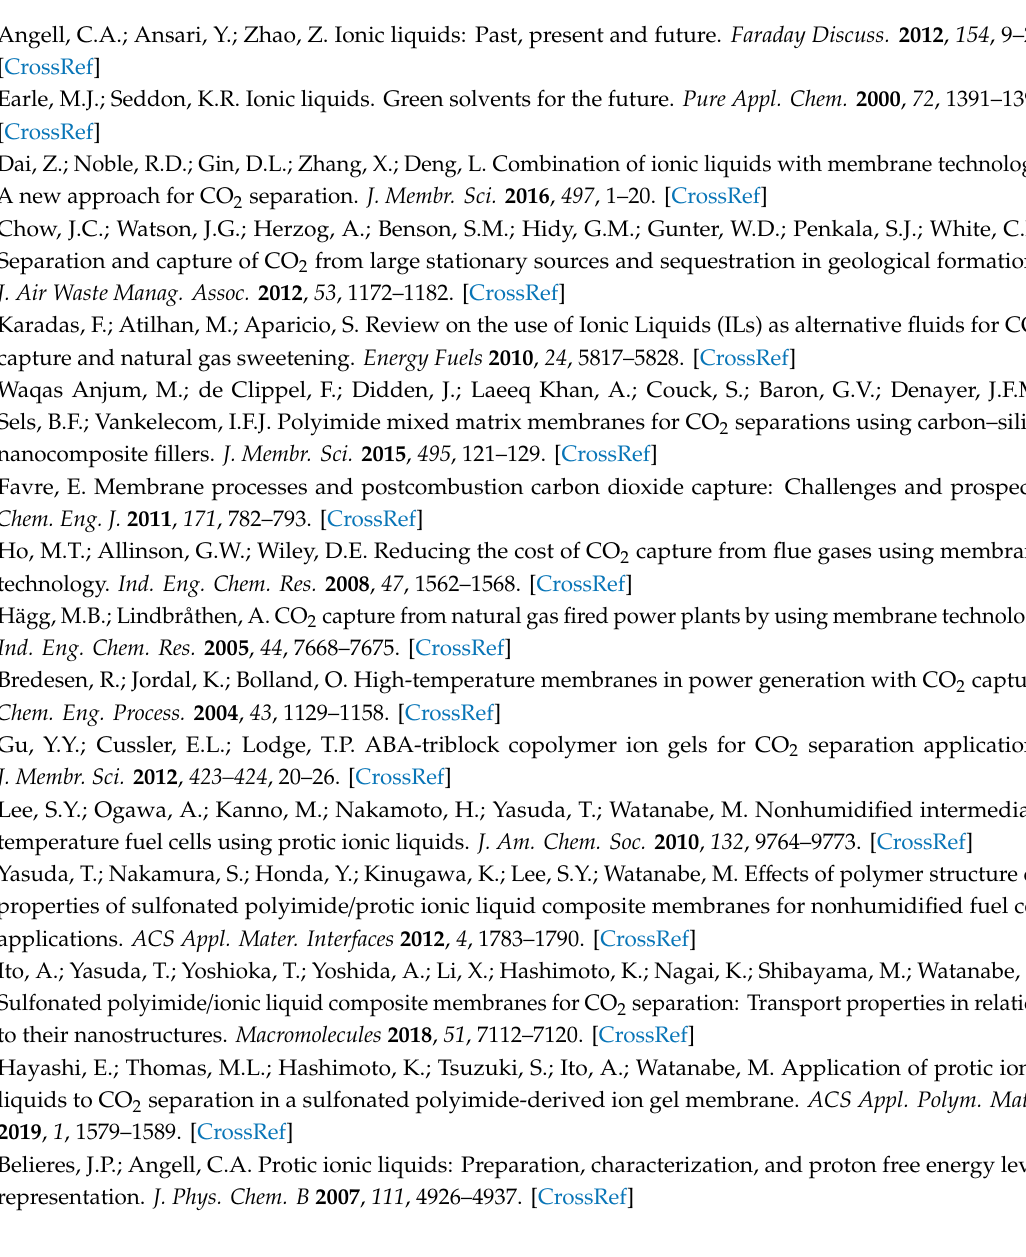
Figure S1: a sketch of the instrument for gas permeability measurements, Figure S2: The most stable structures of [C 3 imH] + –CO 2 , [C 2 mim] + –CO 2 , and [NTf 2 ] − –CO 2 complexes and their stabilization energies. Tables S1 and S2: thermal properties, Table S3: gas permeability, Tables S4 and S5: volumetric expansion and CO 2 solubility, and Table S6: mechanical